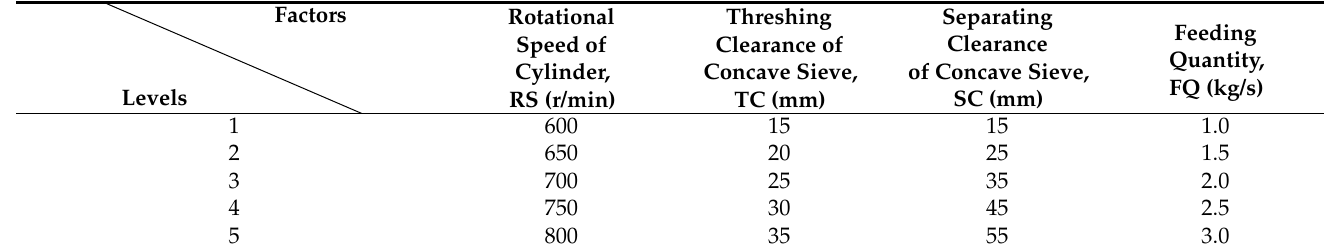
Table 4. Orthogonal test factor level table used for Artificial Neural Network Model Variables.